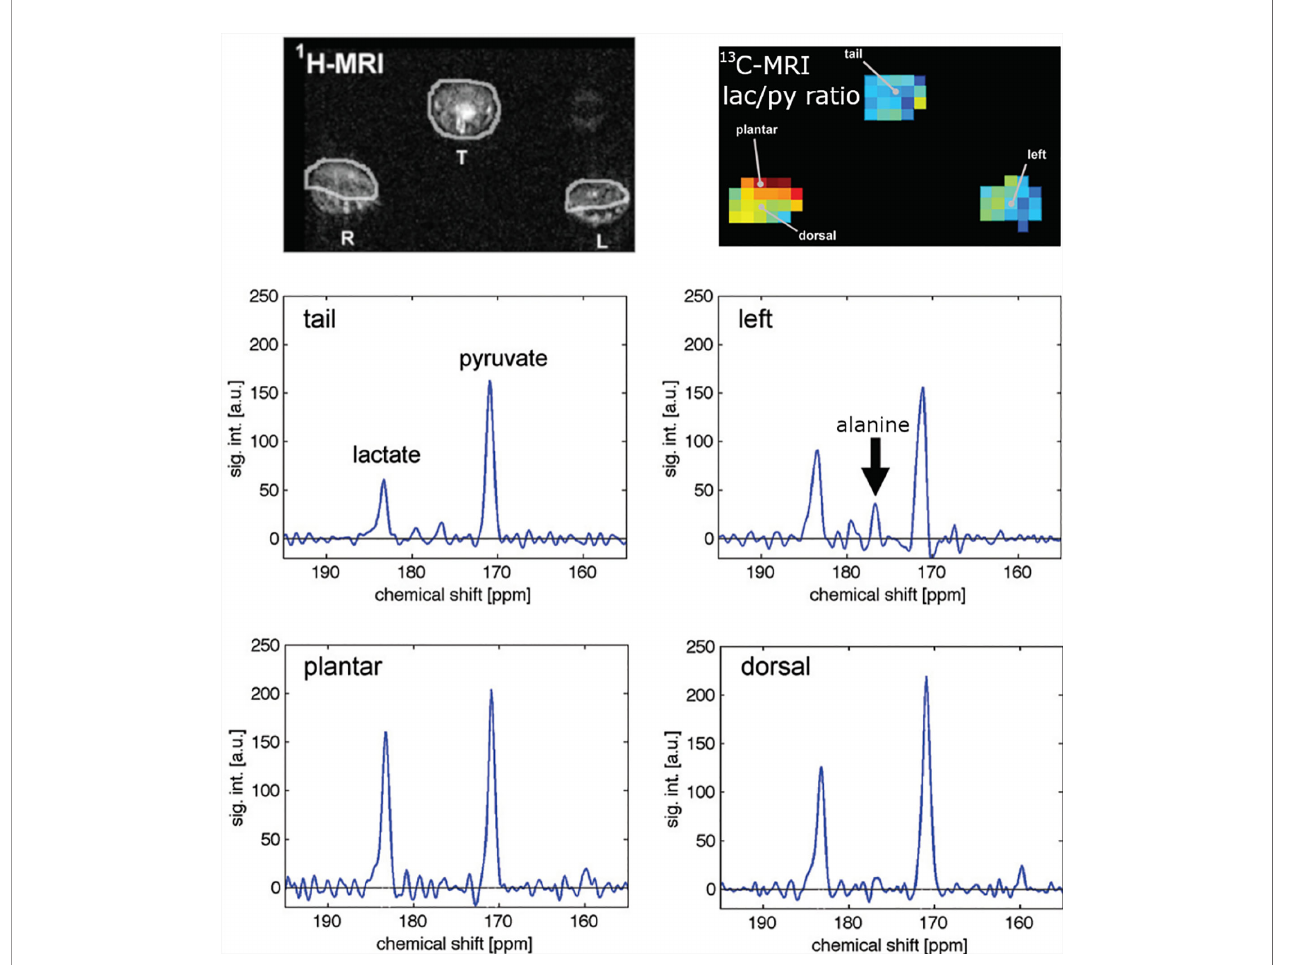
FIGURE 4 | Measuring the metabolism of an arthritis model with hyperpolarized hyperpolarized MRI: anatomical 1H MRI (top left), quantitative metabolic map of lactate-to-pyruvate ratio (top right) and corresponding 13C spectra. Arthritis was induced in the right paw of the rats while the left served as a control. Hyperpolarized pyruvate was injected and 13 C metabolic imaging performed. The in fl amed paw exhibited a 65% increase in lactate signal and no alanine signal indicating abnormal metabolism. Figure modi fi ed from [MacKenzie et al.